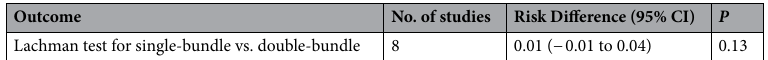
Outcome No. of studies Risk Difference (95% CI) P Lachman test for single-bundle vs. Table 3. Summary of meta-analyses of dichotomous variables. CI confidence interval.